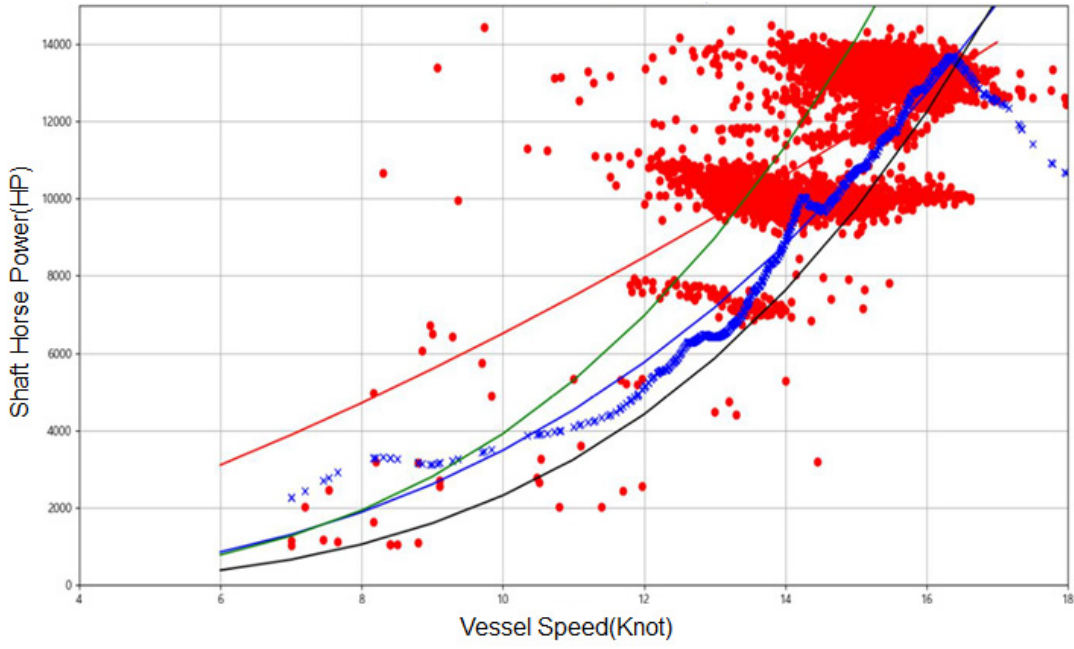
Figure 5. Predicted propulsion power without external effect.